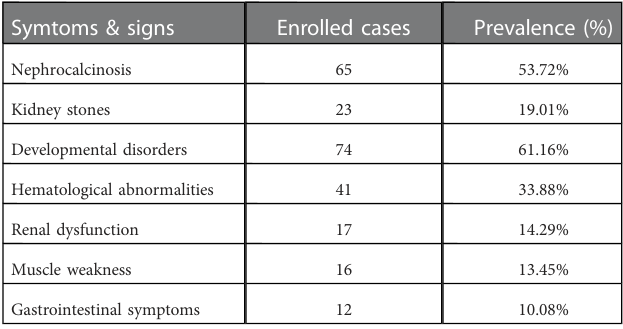
TABLE 2 The clinical manifestations of patients diagnosed as dRTA with mutations in SLC4A1 .